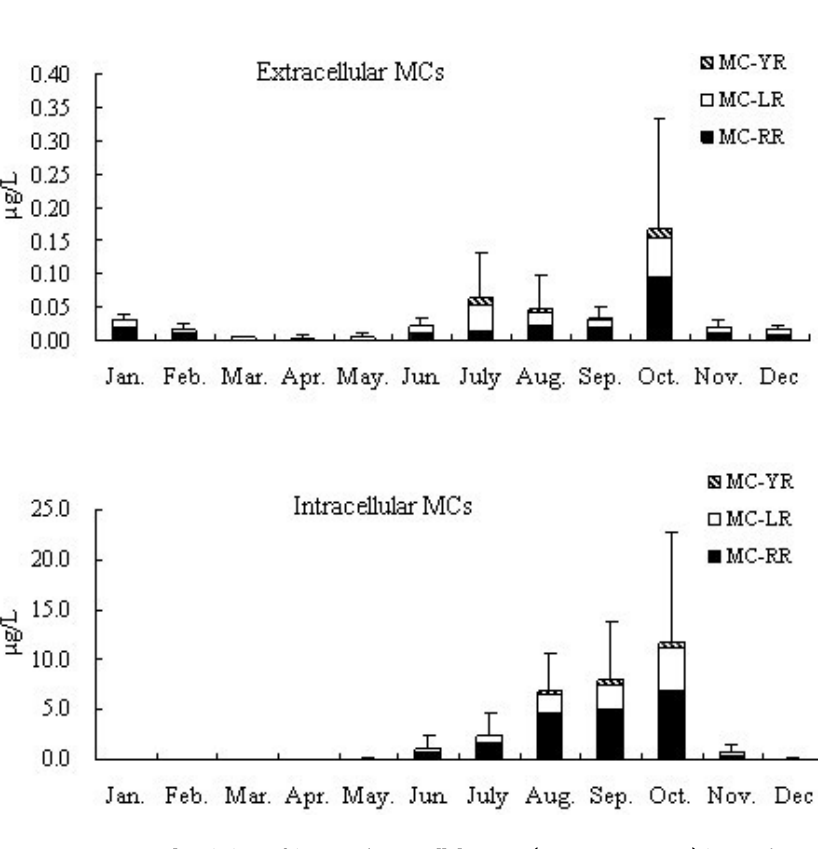
Seasonal Variations of MCs in Representative Sites Seasonal variations of MCs (MC-RR+-LR+-YR) at Sites 3, 4, 13, and 15 in Gonghu Bay are shown in Fig. 4. We found that the intra- and extracellular MCs of Sites 3 and 4 reached peaks in October, which at Site 13 reached peaks in September. The intracellular MCs of Site 15 reached peak in October and extracellular MCs reached peak in